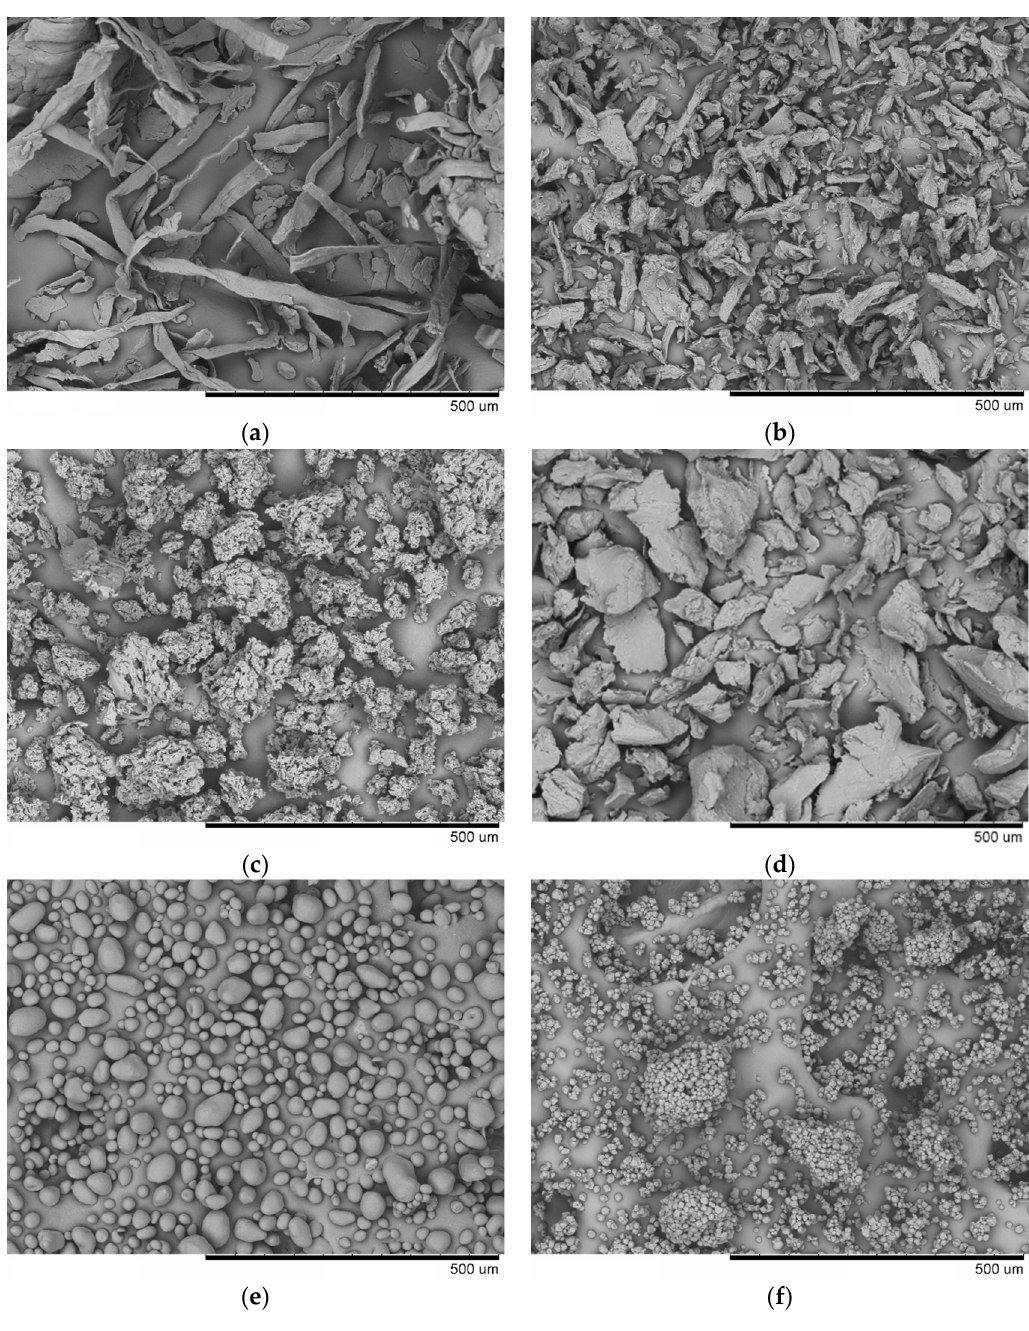
Figure 1. Scanning electron microscopy (SEM) images of study objects: ( a ) α -cellulose, ( b ) sigmacell cellulose, ( c ) β -glucan, ( d ) konjac gum, ( e ) potato starch, and ( f ) corn starch.